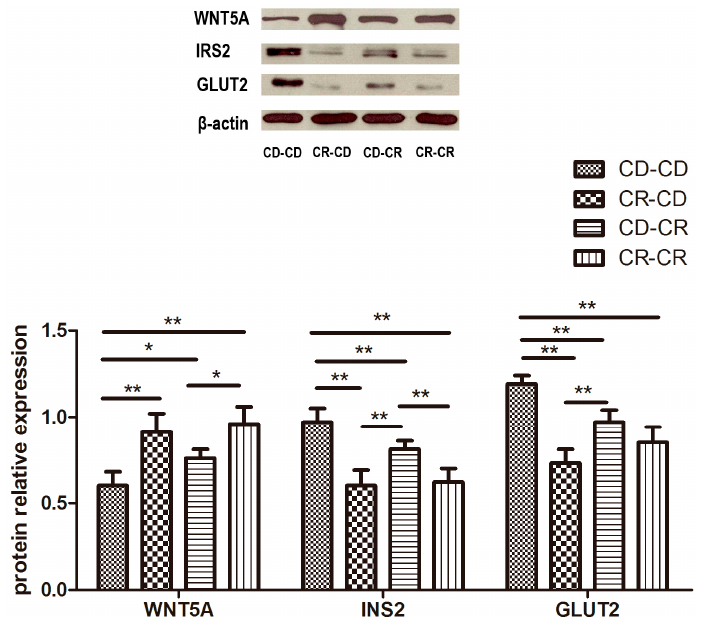
Figure 4. The protein levels were detected by Western blot. IRS2: insulin receptor substrate 2; SLC2A2 (GLUT2): solute carrier family 2 member 2; WNT5A: wingless-type MMTV integration site family, member 5A. CD, control diet; CR: chromium restriction. n = 8 per group, * p < 0.05, ** p < 0.01.